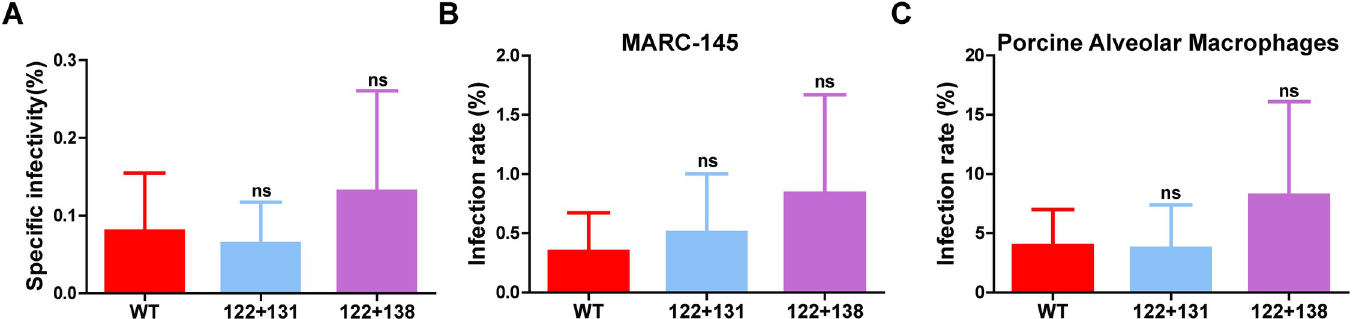
Fig 9. Palmitoylation of GP5 is not required for cell entry of PRRSV. (A) Specific infectivity of virus particles: The supernatant of MARC-145 cells infected at a MOI of 0.01 with PRRSV wildtype or mutants GP5 122+131 or GP5 122+138 were removed at 48 hours after infection. The cleared and benzonase-treated supernatant was used to determine the number of infectious particles with the TCID50 assay and the number of total virus particles by qRT-PCR. The specific infectivity (number of infectious particles divided by the number of total particles) was calculated for three different supernatants. (B +C) Cell entry assay: MARC-145 cells (B) or PAMs (C) were inoculated with 1x10 5 particles as determined by qRT-PCR in paralell. Infected cells were visualized by immunofluorescence using antibodies against the PRRSV nucleocapsid protein (see S4 Fig) and counted. One-way ANOVA followed by Tukey’s multiple comparison test revealed no significant difference between PRRSV wildtype and GP5